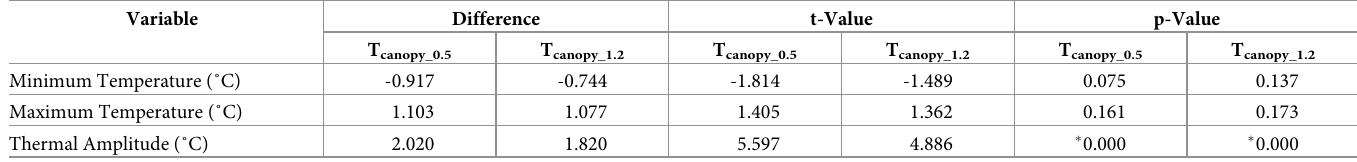
Table 1. T-test comparison between daily air temperature measured under standard conditions (T station_1.7 ) and within the canopy at a height of 0.5 and 1.2 m above the soil surface (T canopy_0.5 and T canopy_1.2 ). The temperature was recorded between December 2015 and June 2017.